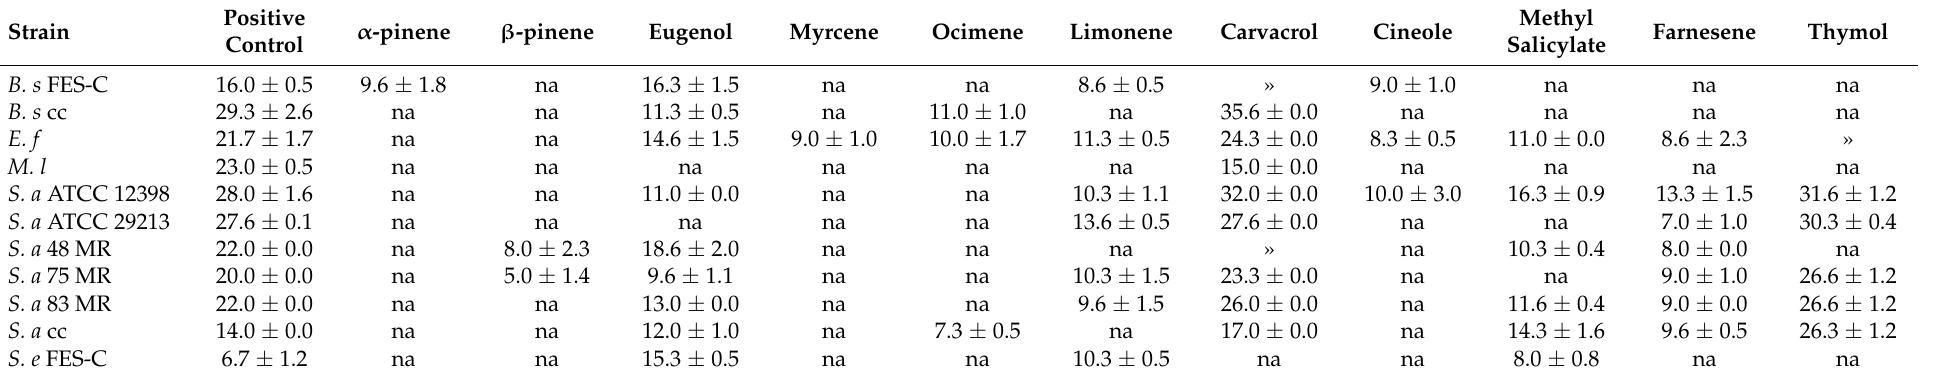
Table 1. Antimicrobial activity of some compounds in Gram-positive strains.